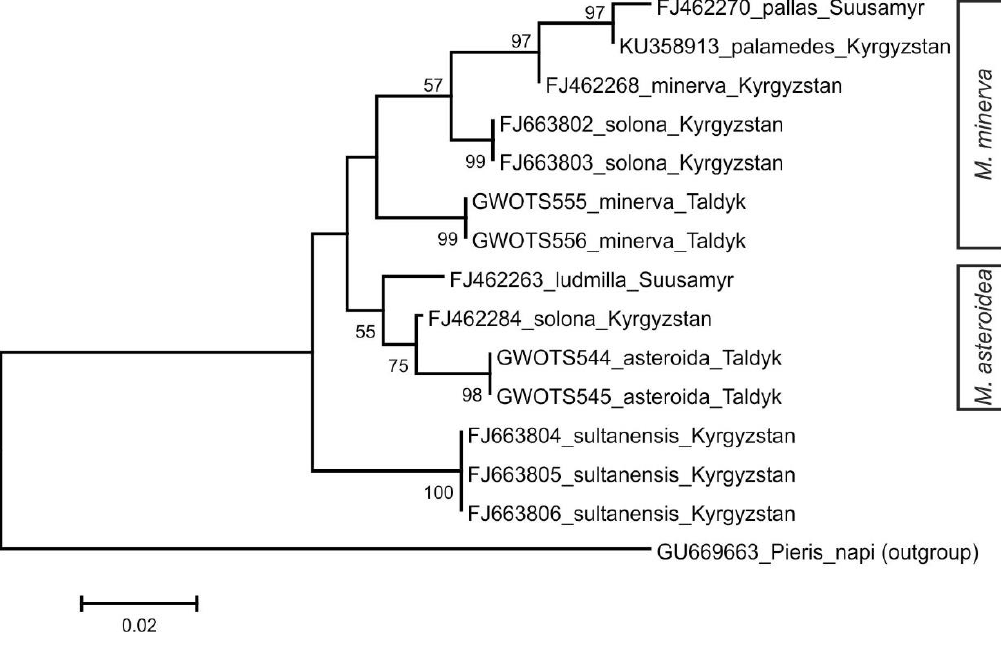
Рис. 7. Кладограмма филогенетических связей в группе M. minerva, последовательность COI. Метод